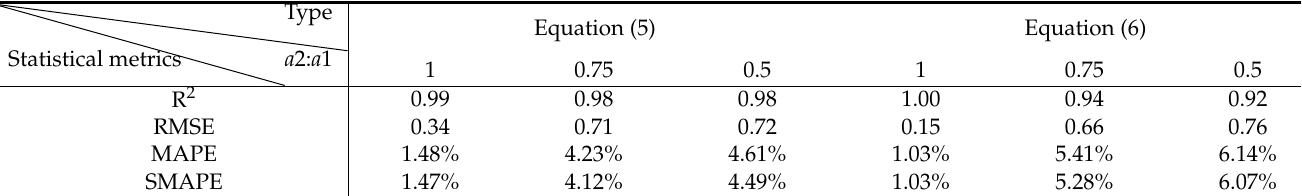
Table 4. Statistical metrics of Equations (5) and (6).